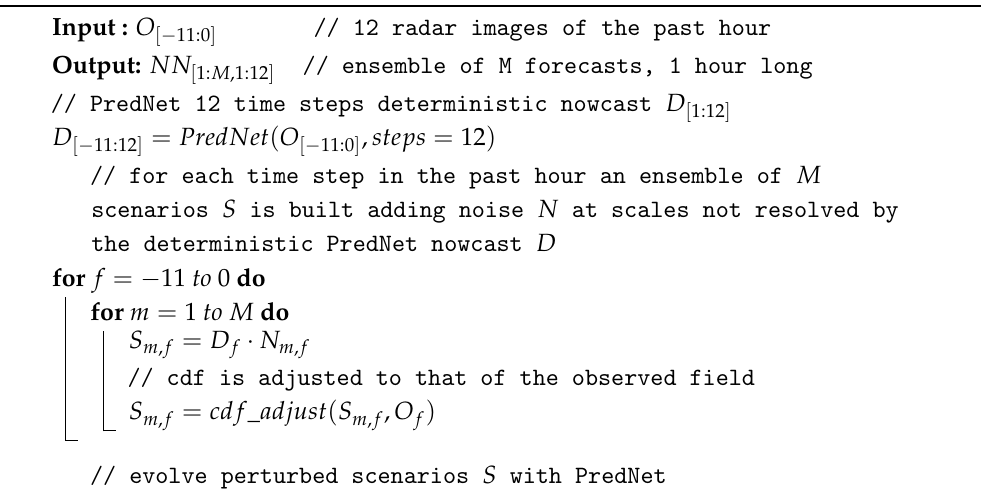
Algorithm 1: Pseudocode of the stochastic PredNet